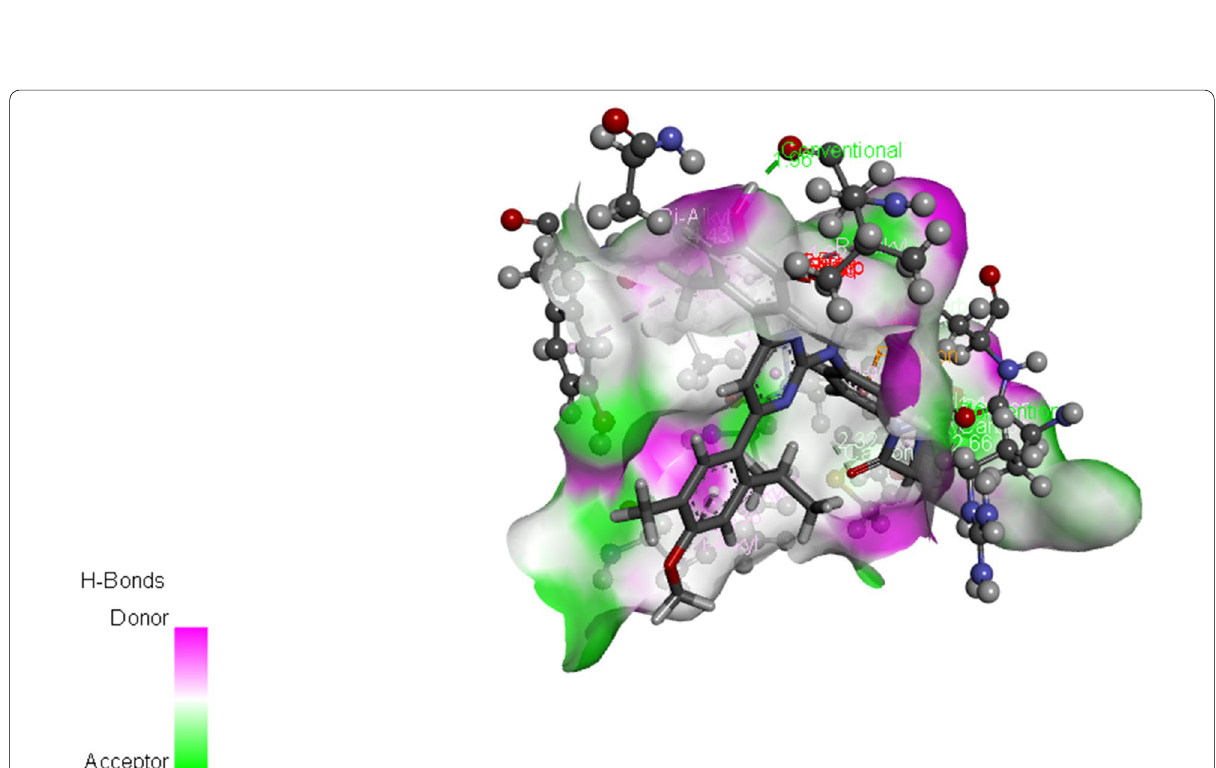
Fig. 10 3D structure of the designed compound 3 interactions with VEGFR-2